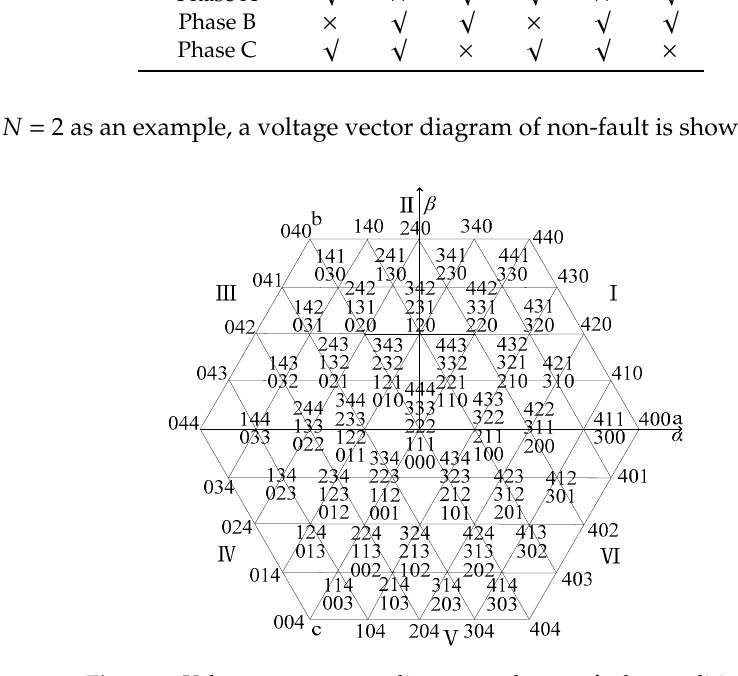
Figure 3. Voltage space vector diagram under non-faulty condition.